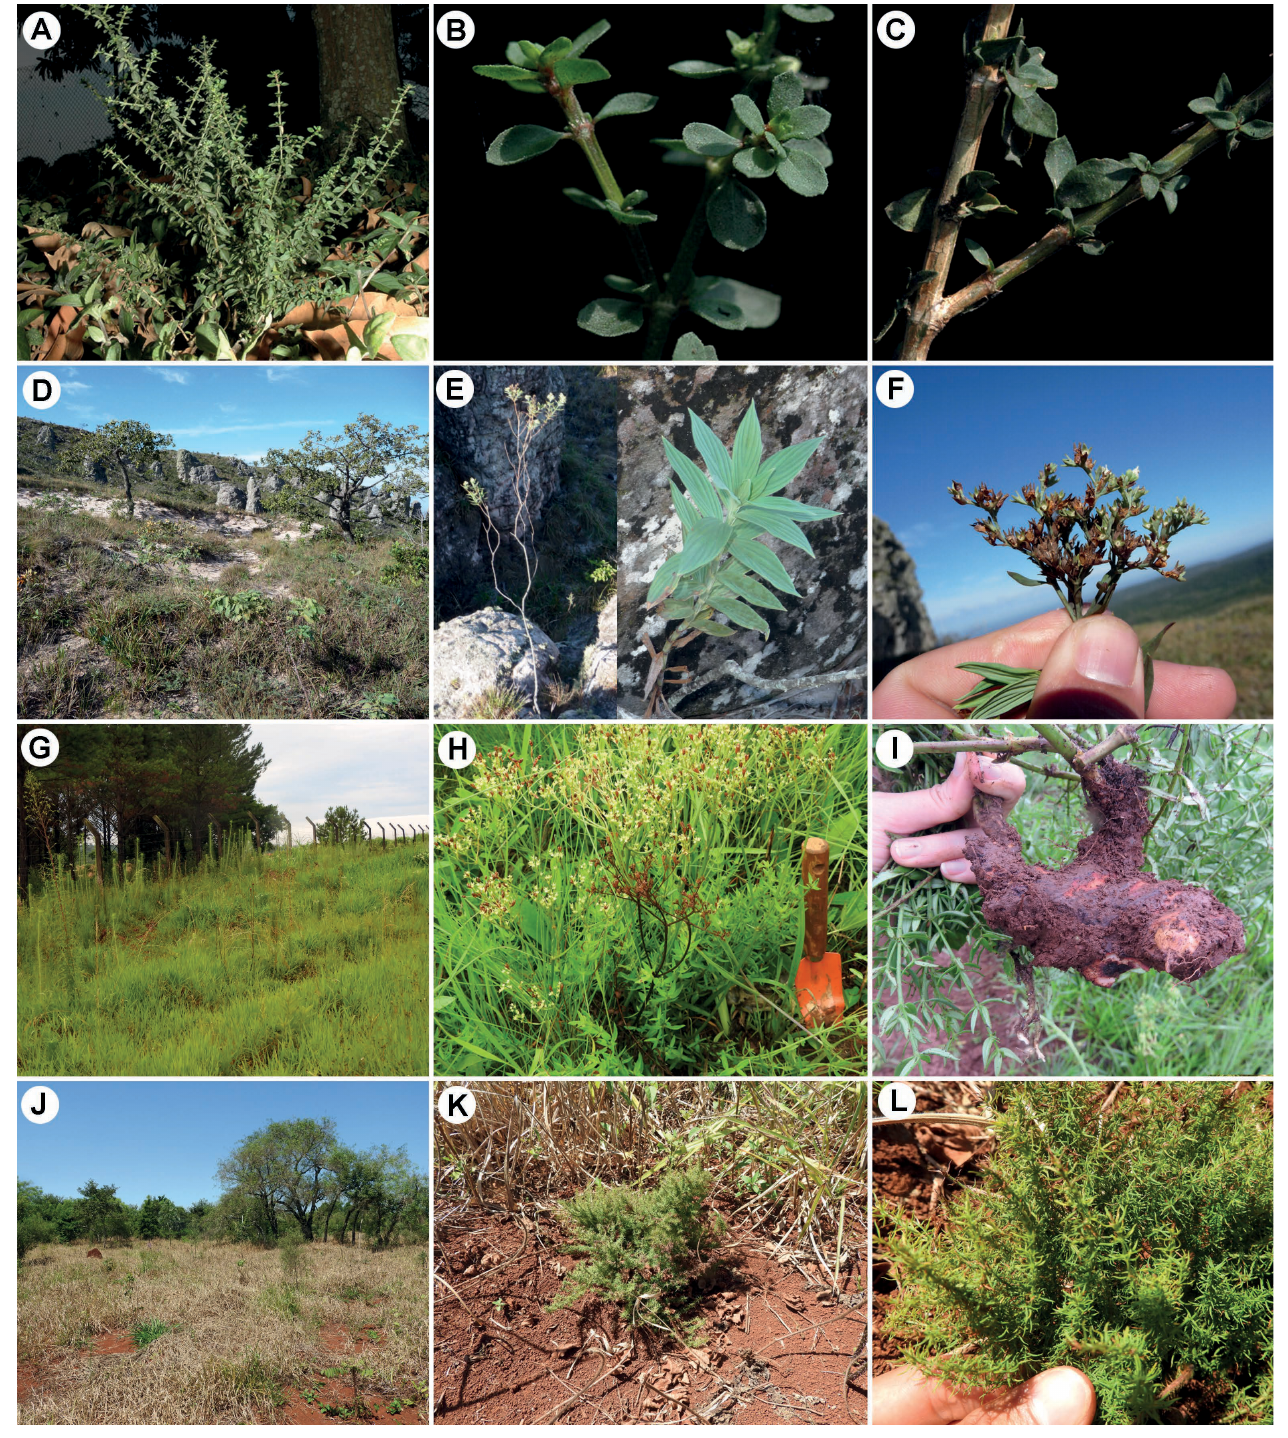
Figure 4 – Species that represent isolated tracks: A–C, Galianthe angulata ; D–F, G. chiquitosiana ; G–I, G. elegans ; J–L, G. linearifolia . A, E, H & K, habit; D, G & J, habitat; B & L, leaves; I, xylopodioum; C, portion of a branch; F, inflorescence. A–C photographed by Pedro Tenorio Lezama, plantae mexicanae tenorianae; D–F photographed by R. Salas; G–L photographed by J.E.